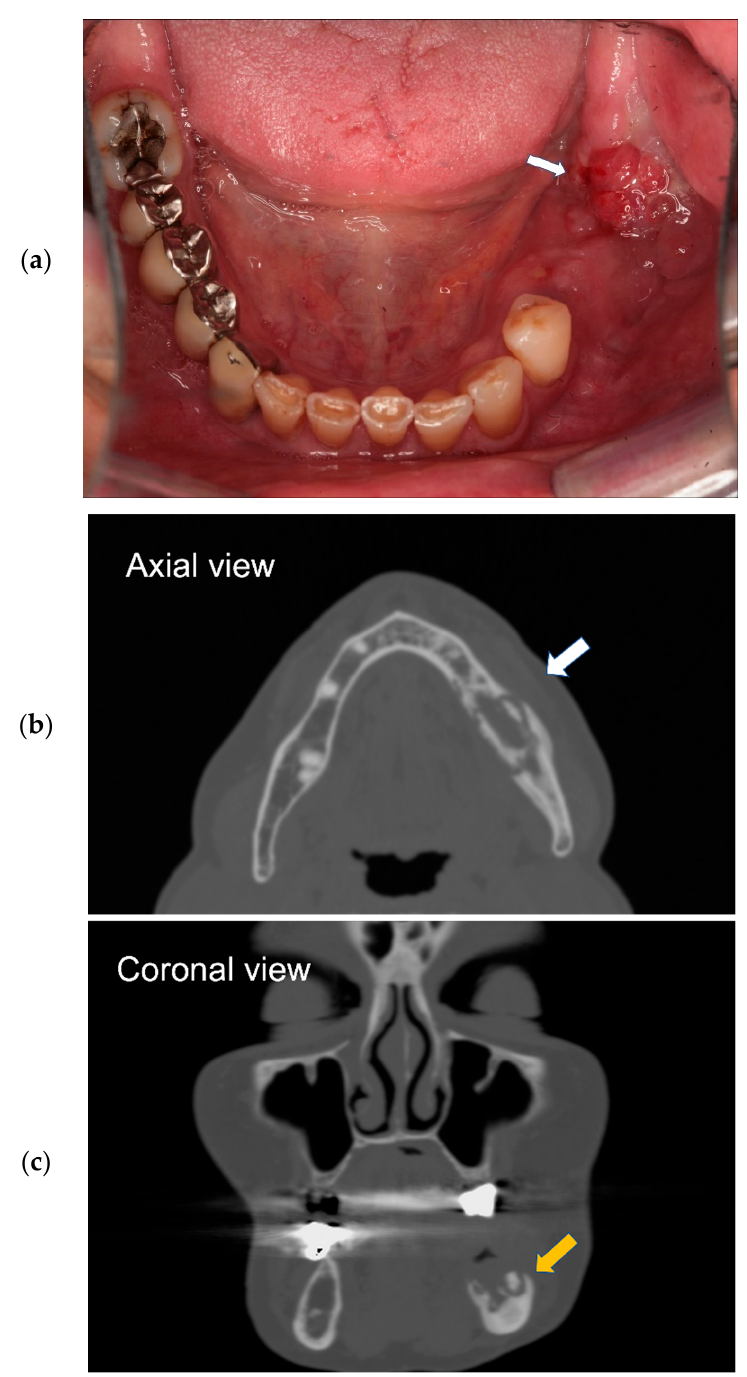
Figure 2. Stage 2 according to SICMF-SIPMO staging system: Diffuse MRONJ. ( a ) Non-exposed MRONJ following simple tooth extraction; the alveolar socket is filled up with inflammatory tissue (white arrow); the bone can be probed through the fistula. ( b , c ) CT scan axial view showing increased bone density (diffuse bone condensation and osteosclerosis) of the left mandibular body with sequester formation and periosteal reaction (white arrow); in the coronal view, the increased bone density signal is extended to the basal bone, with the loss of cortical and trabecular bone differentiation (yellow arrow).